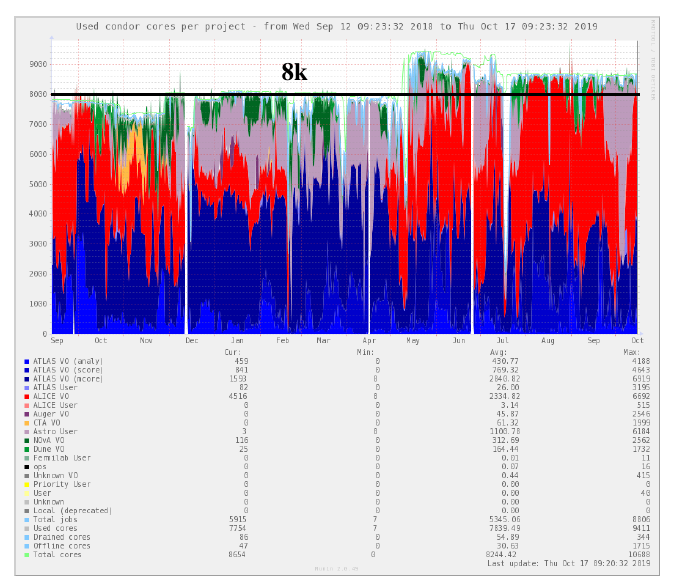
Figure 2. Batch slots usage in the HTCondor between September 2018 and October 2019. Colours represent di ff erent VOs but also di ff erent activities of a